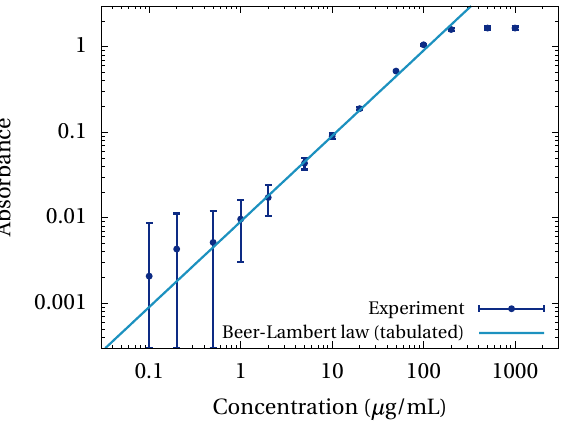
Figure 3. Calibration of methylene blue absorbance around 500 nm with an optical path of 1 cm. Data points represent averages over one cuvette image (per concentration value), error bars show one standard